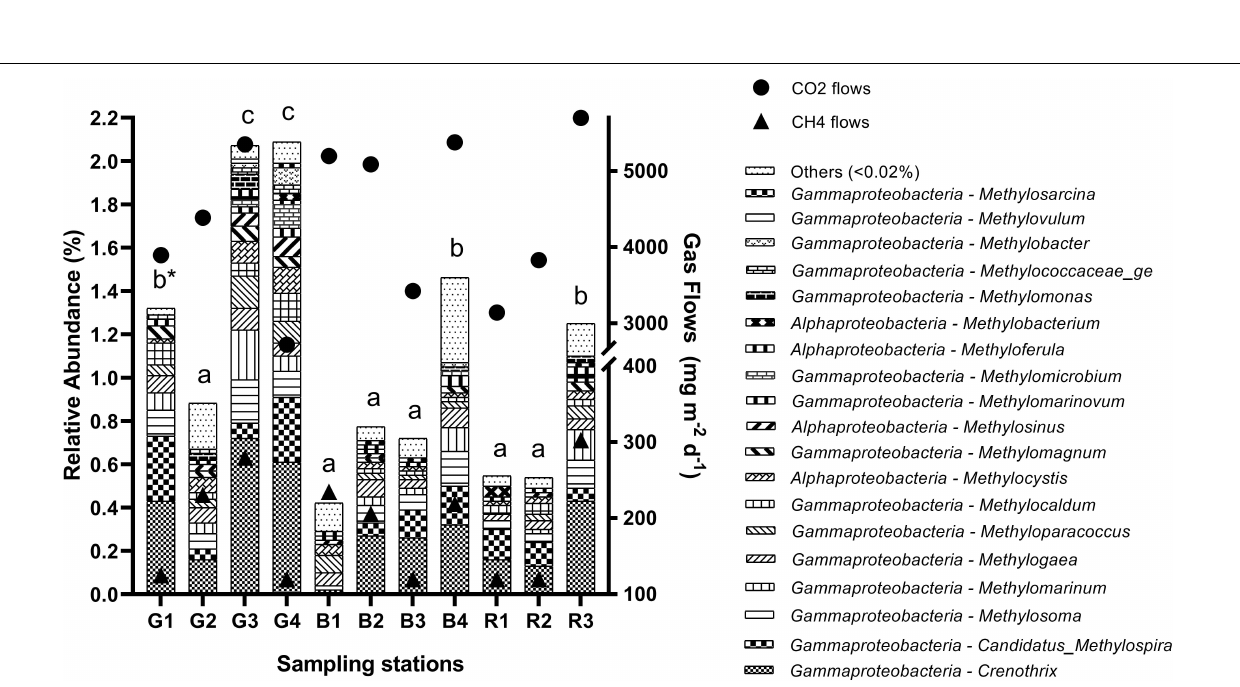
FIGURE 5 | Relative abundance of aerobic methanotrophic genera in the sediment of reservoirs and the atmospheric CO 2 and CH 4 flows throughout the sampling stations. “Others” refers to a group of genera with abundances lower than 0.02%. *Means with equal letters do not differ by the Scott–Knott test at 5% significance to methanotrophs